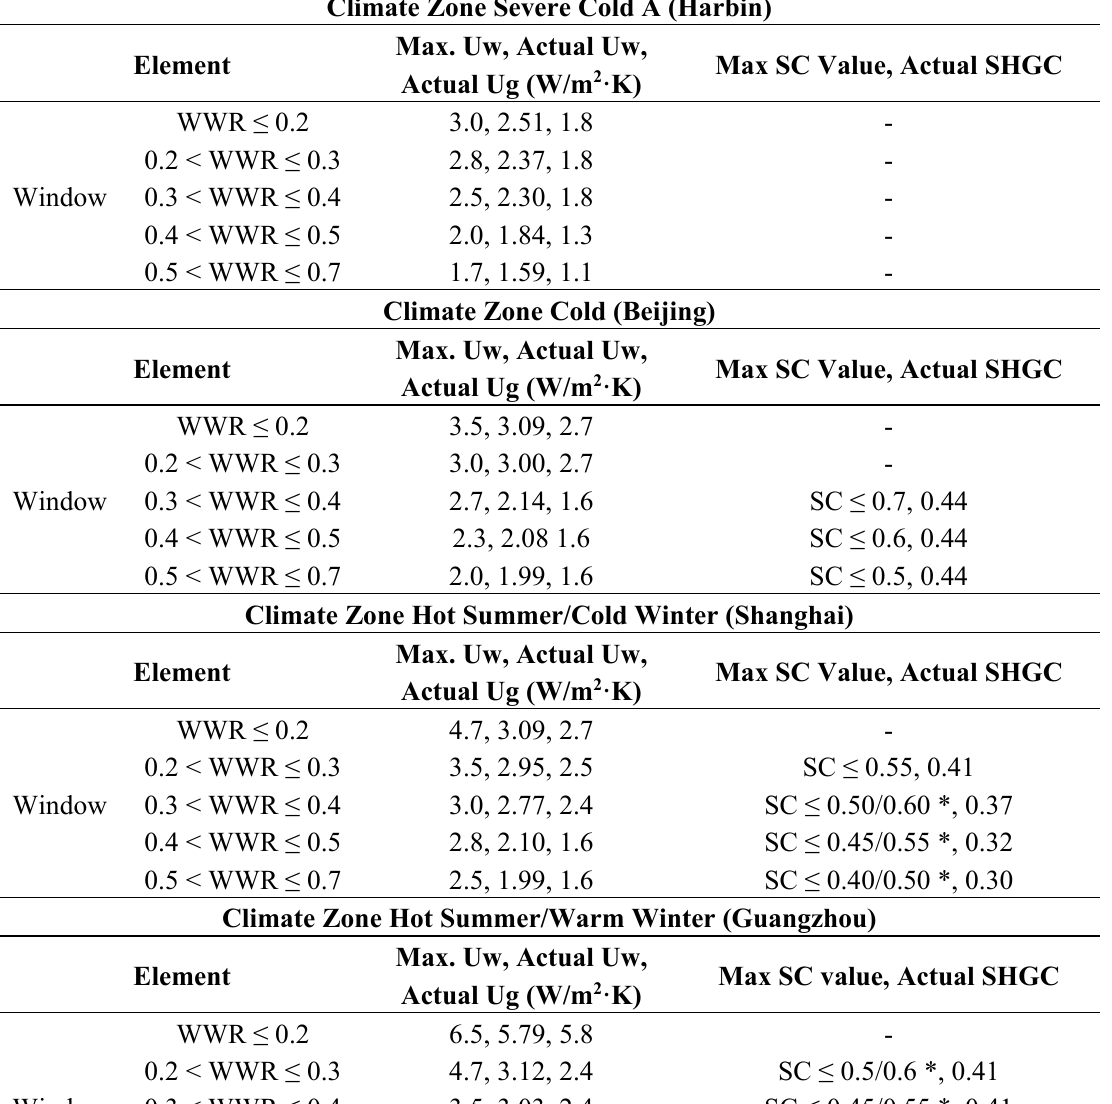
Table 1. Prescriptive building envelope requirements defined by the GB 50189-2005